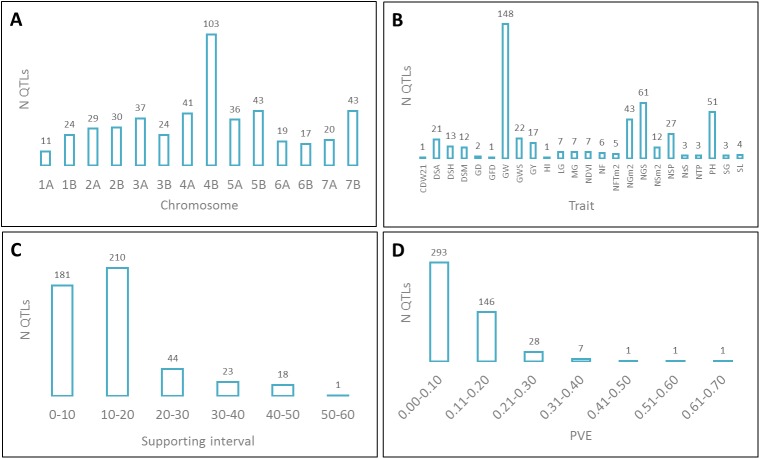
Parameters estimated in QTL studies collected for meta-analysis.Number of QTLs per A) chromosome, B) trait, C) supporting interval (cM) and D) phenotypic variance explained.